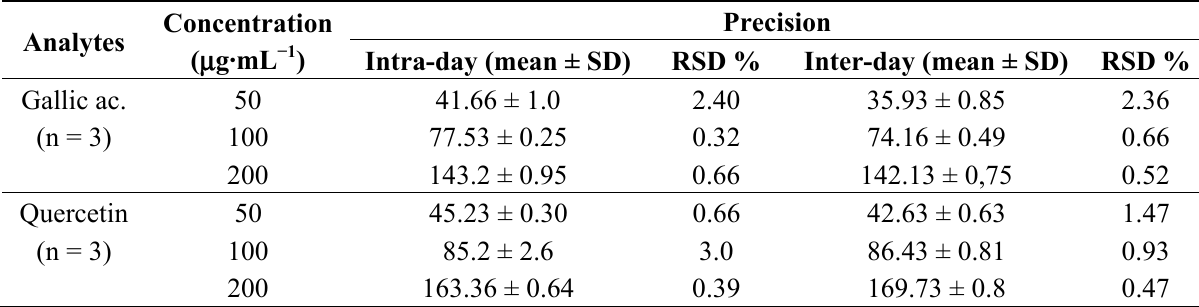
Table 2. Precision data of the two analytes, expressed as RSD (%).